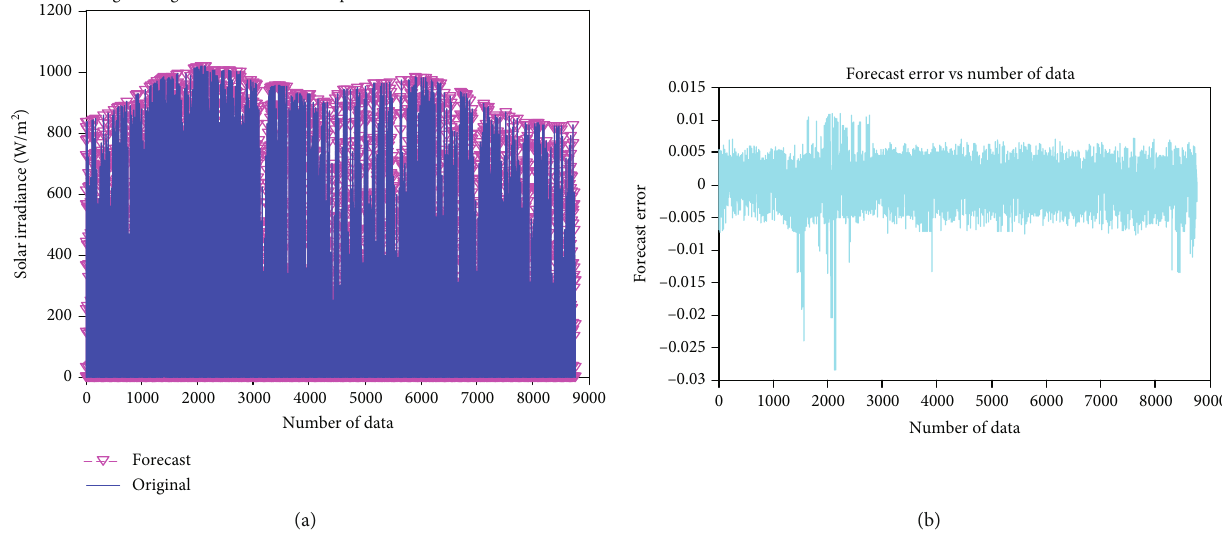
Figure 5: (a) Two input MLPNN-based forecasting model original targets compared to forecast solar irradiance. (b) Two input MLPNN- based forecasting model forecasting errors vs. the number of data